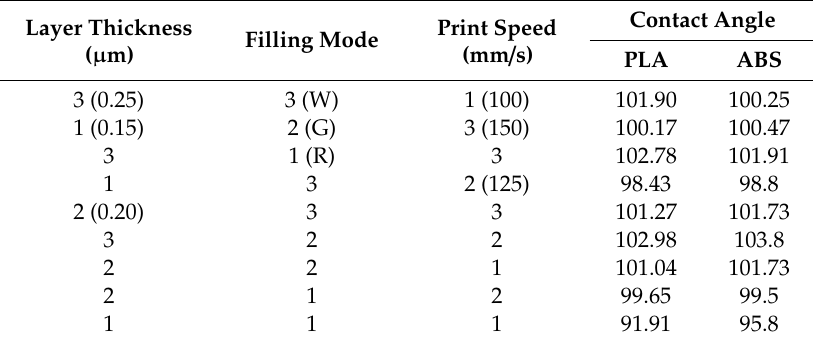
Table 7. Experimental result of contact angle.